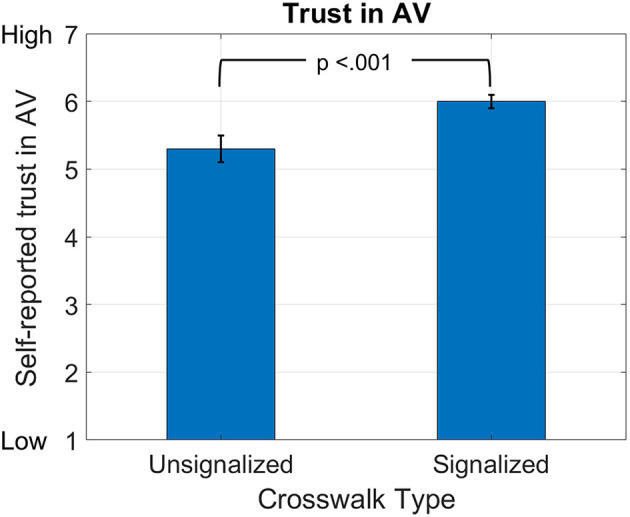
Main effects of signalized crosswalks. Higher self-reported AV trust in signalized conditions.